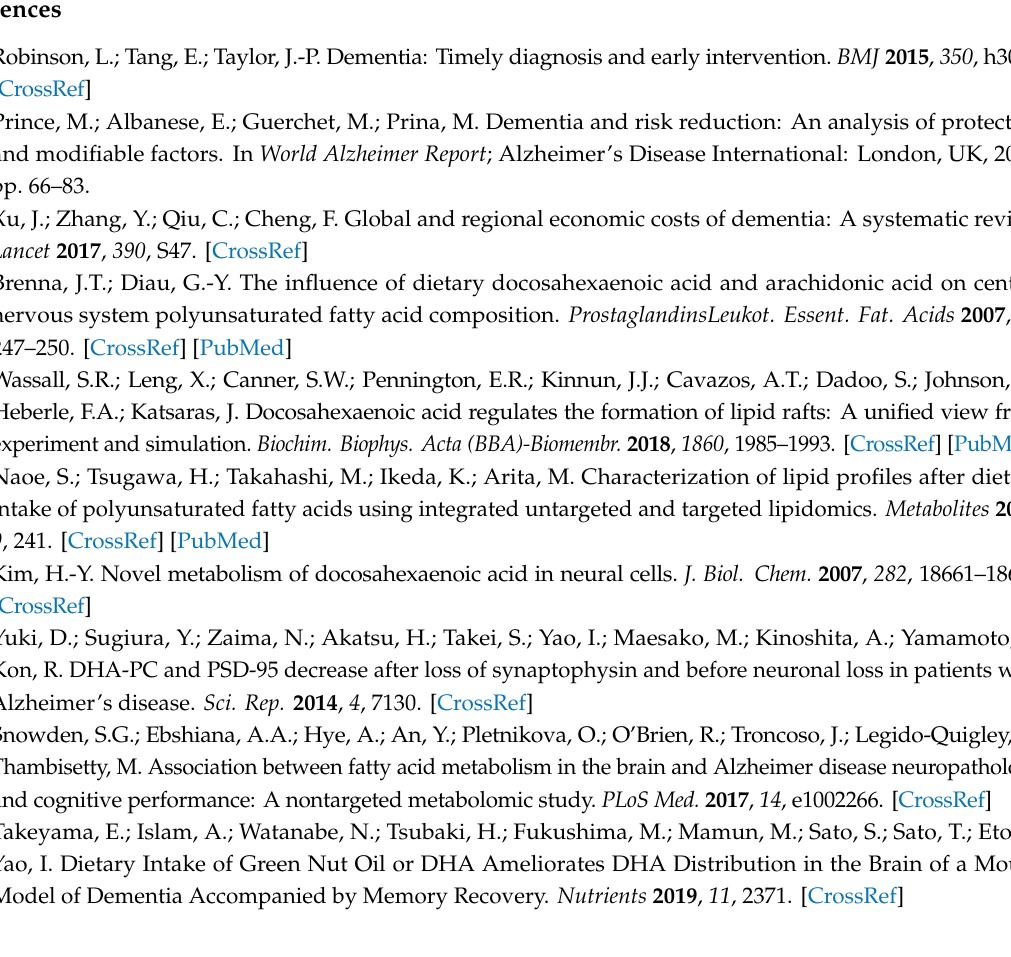
Figure S1: Representative mass spectra of DESI-MSI acquired in positive ionization mode from the sagittal brain sections of 14-week-old WT and SAMP8 mice. Figure S2: Average intensity of the distribution of DHA-PCs in the brain of 14-week-old WT and SAMP8 mice (data from three independent experiments),Table S1: Fold decreases in the average intensity of the distribution of DHA-PCs in di ff erent brain regions of 14-week-old SAMP8 mice compared to WT mice, Figure S3: Average intensity of the distribution of DHA-PCs in the brain of 28-week-old CO, GNO, and DHA treated SAMP8 mice (data from five independent experiments), Table S2: Fold increases in the average intensity of the distribution of DHA-PCs in di ff erent brain regions of GNO or DHA treated SAMP8 mice (28 weeks old) compared to CO treated SAMP8